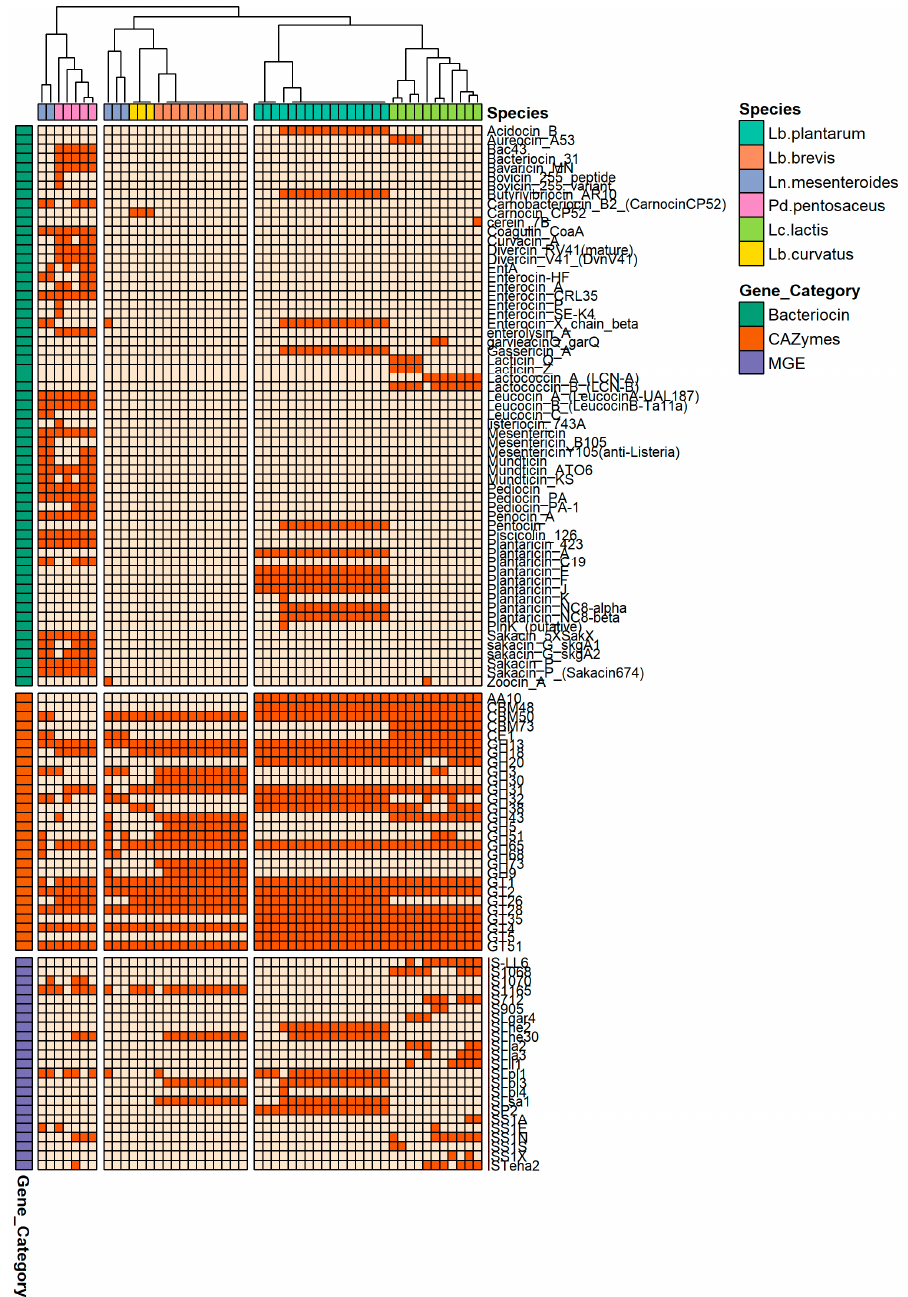
Figure 3. Clustered heatmap generated using a presence-absence data matrix of MGEs, CAZymes, and bacteriocins of all LAB isolates (n = 51). Each column represents one isolate and each row one genomic element. Isolates and genomic elements are color-coded according to the legend. Presence (dark orange) or absence (light orange) of the element in the respective isolates is shown.